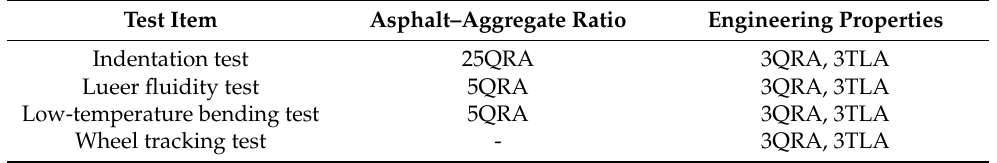
Table 5. The preparation of specimens.